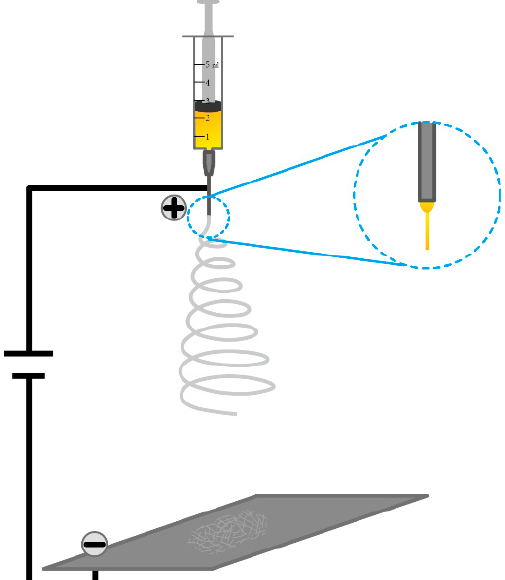
Figure 1. Schematic diagram of the electrospinning setup.